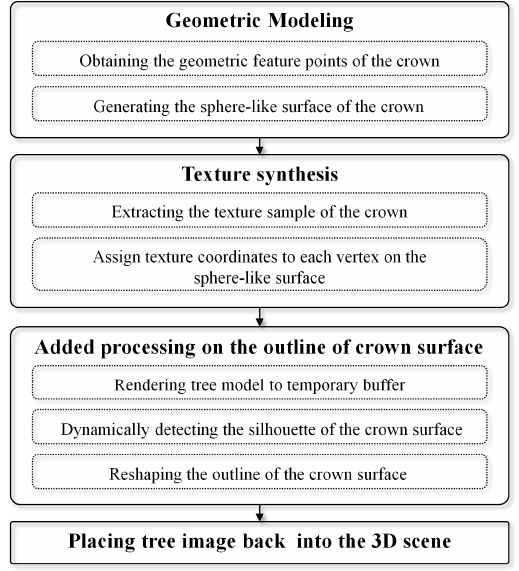
Figure 5. Process of the technique.